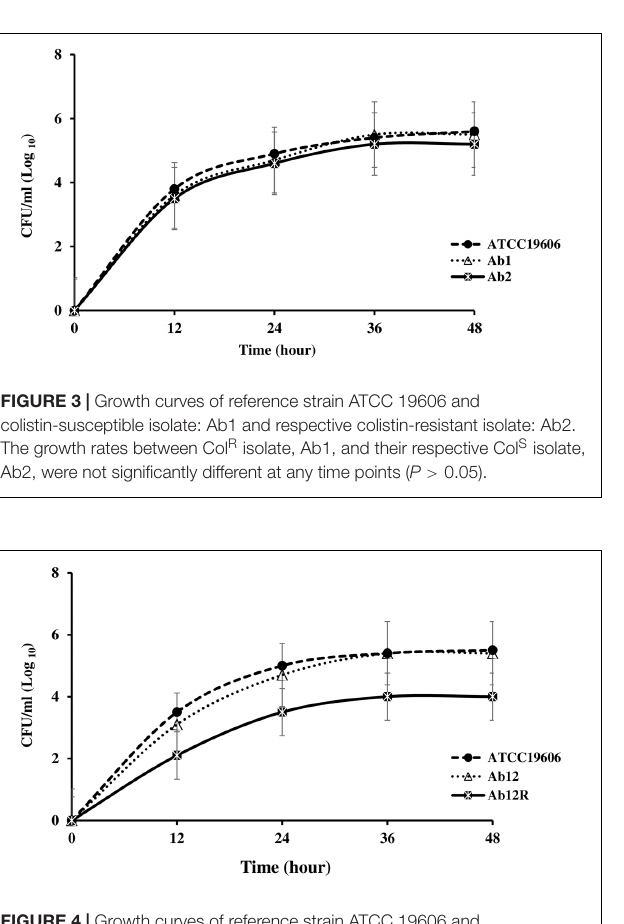
FIGURE 4 | Growth curves of reference strain ATCC 19606 and colistin-susceptible isolate: Ab12 and respective colistin-resistant isolate: Ab12R. There was a significant ( P < 0.05) difference in cell count at all times points between susceptible isolate Ab12 and its resistant partner